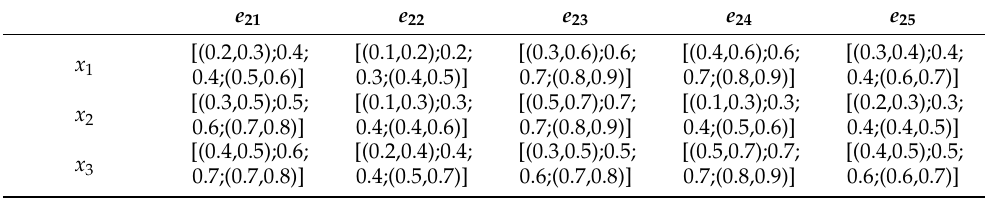
Table A7. The different risk evaluation values subordinated by influencing factors of B 2 at time t 2